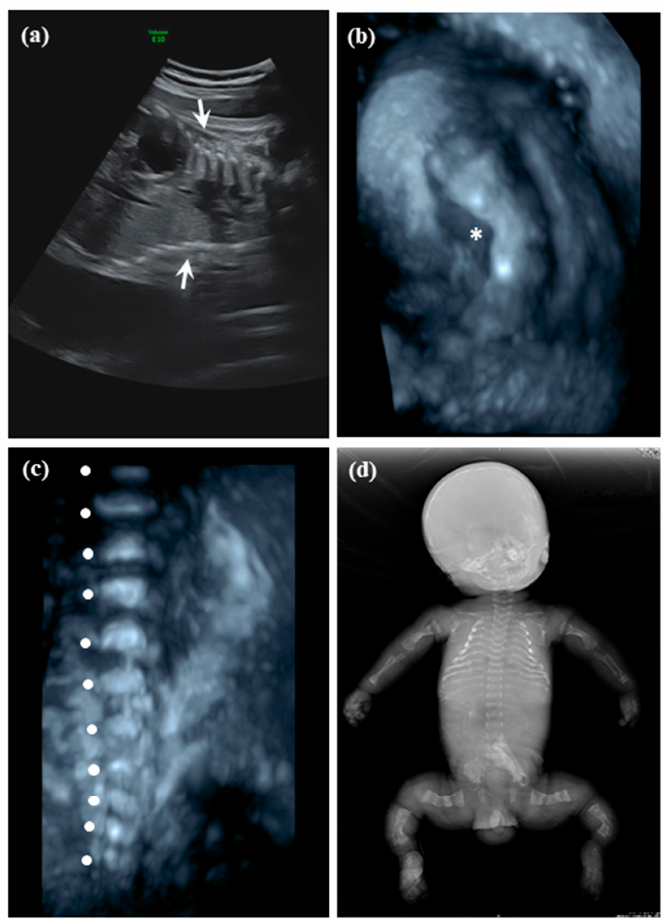
Figure 2. Prenatal ultrasonography of Patient 2 (a male fetus) with OI IX in Family 2 at GA = 34 weeks and 1 day showed ( a ) small and collapsed thoracic cage (arrow), ( b ) bowing of femoral bone (star), and ( c ) platyspondyly of spine (filled circle). Postmortem whole-body x-film showed ( d ) ribbon like ribs, multiple bowing and fractures of general gracile bones, and pseudoarthrosis of long